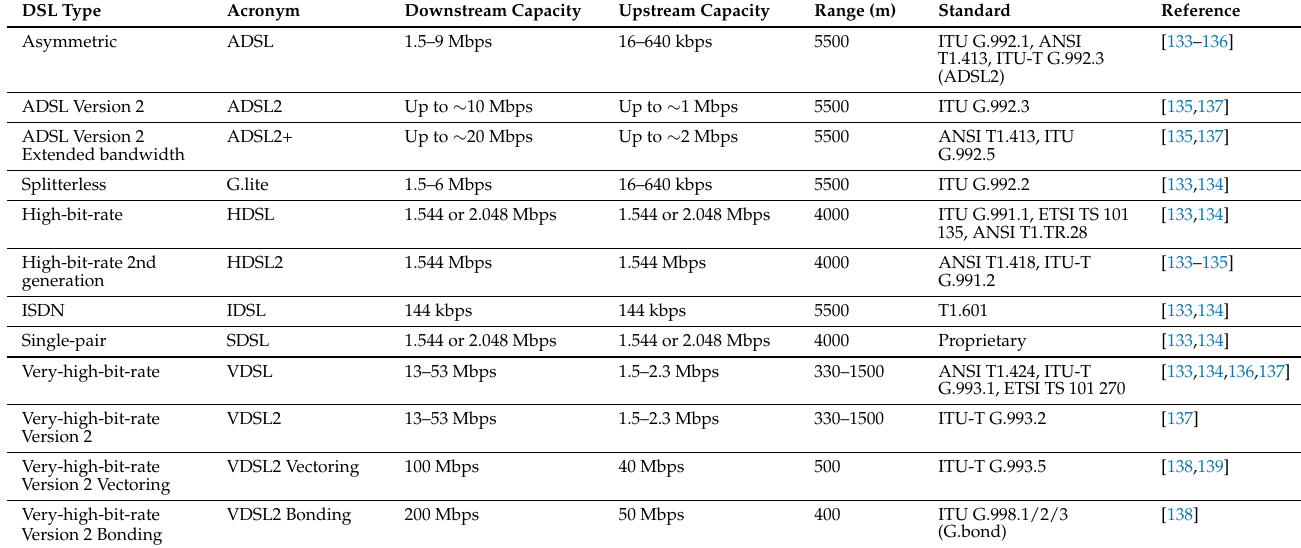
Table 2. DSL technology types and